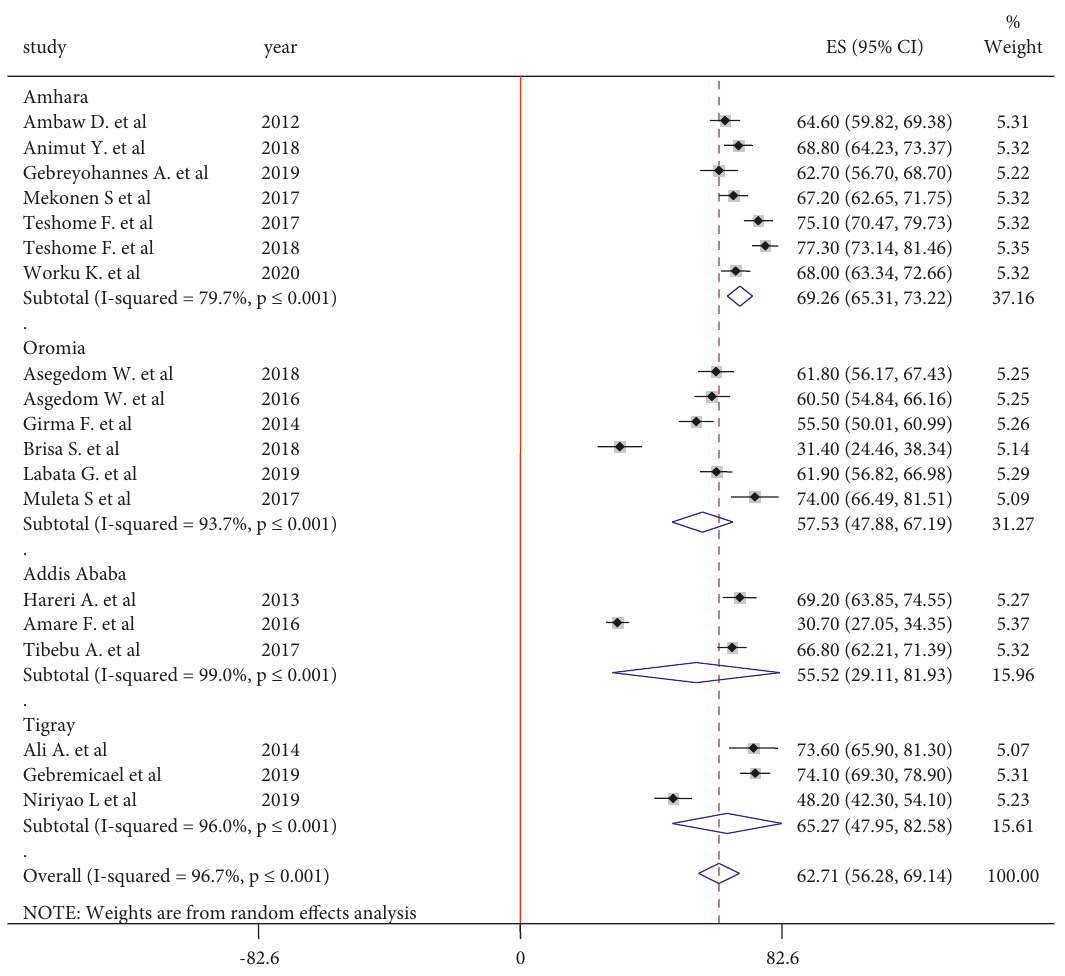
Figure 4: Subgroup analysis for medication adherence among hypertensive patients in